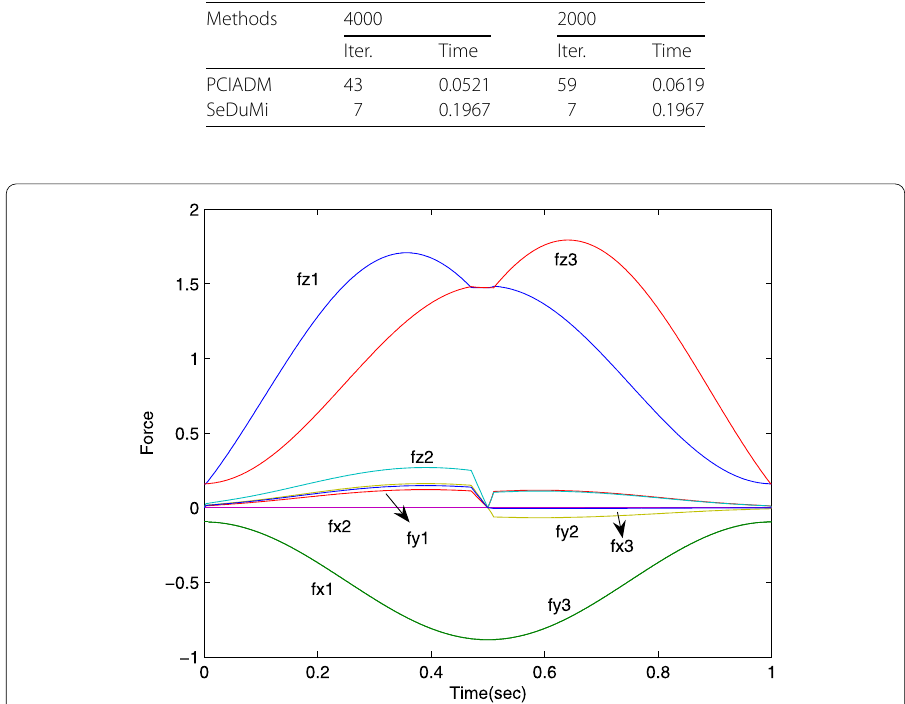
Figure 1 Thetrajectoriesofforcesfor 4000 FOPsbythePCIADMmethod . The optimal forces for the 4000 force optimization problems solved by the prediction-correction inexact alternating direction method are shown